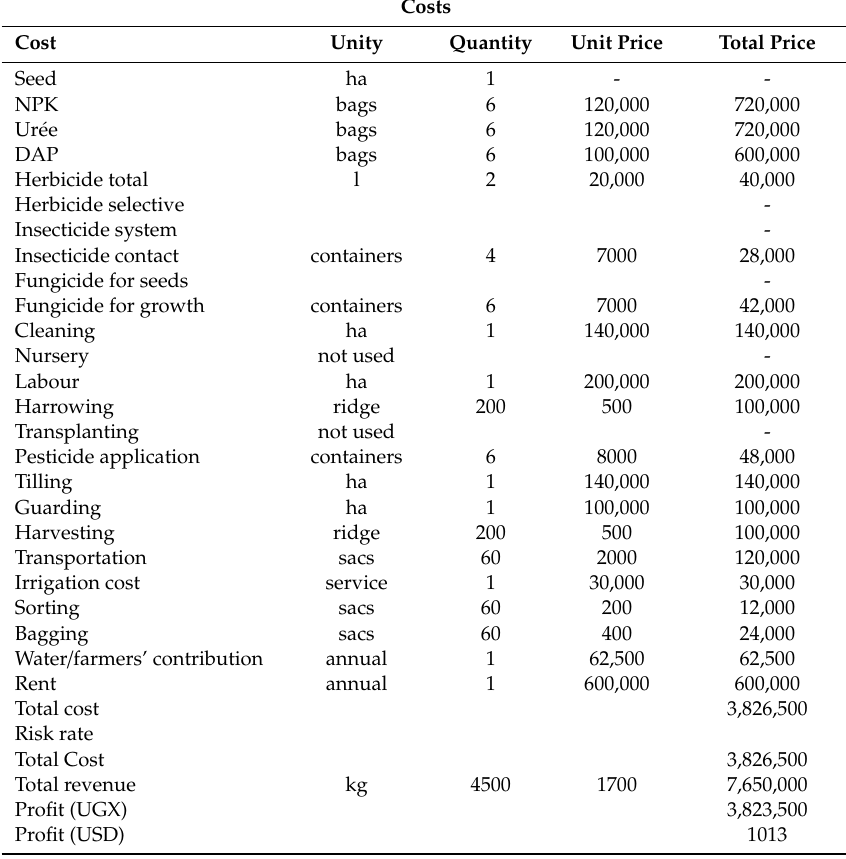
Table A1. Cost-benefit analysis of maize production (in UGX) in Mubuku, 2018.